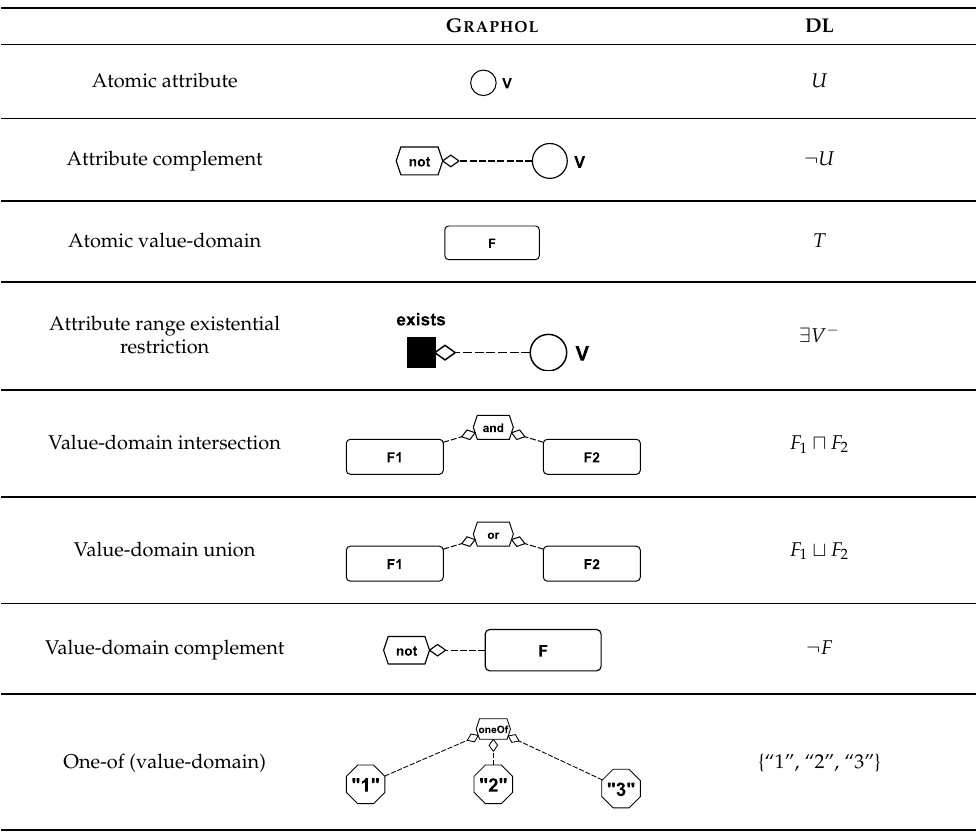
Table 3. Correspondence between G RAPHOL and DL for attribute and value-domain expressions of depth 0 or 1. V denotes an atomic attribute, and F , F 1 , and F 2 denote an atomic